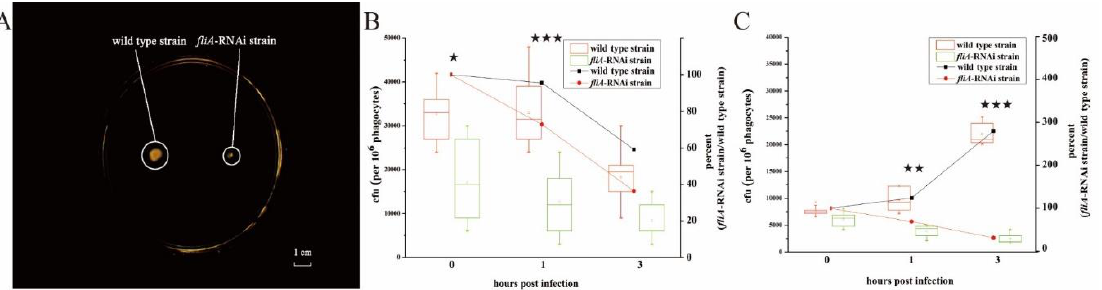
Figure 2. Characterization of the fliA -RNAi strain and wild type strain of P. plecoglossicida . ( A ) Motility. ( B ) Survival rate in phagocytes. ( C ) Escape rate from phagocytes. The right y-axis in Figure 2B,C represent the percent of pathogen cfu number of fliA-RNAi strain group to wild type strain